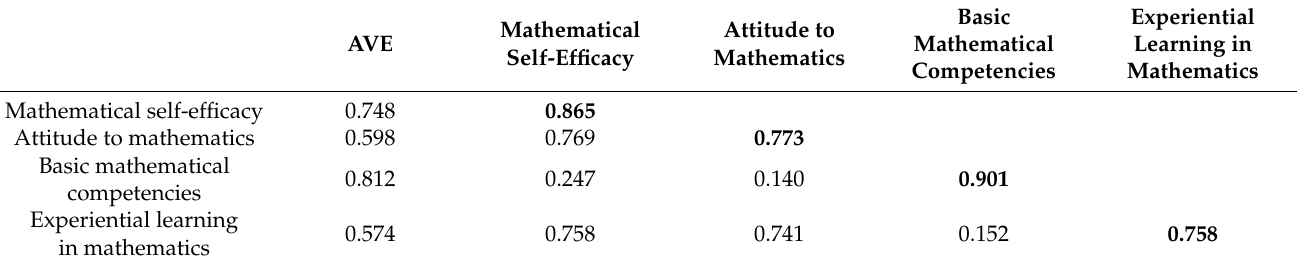
Table 2. Construct differential validity